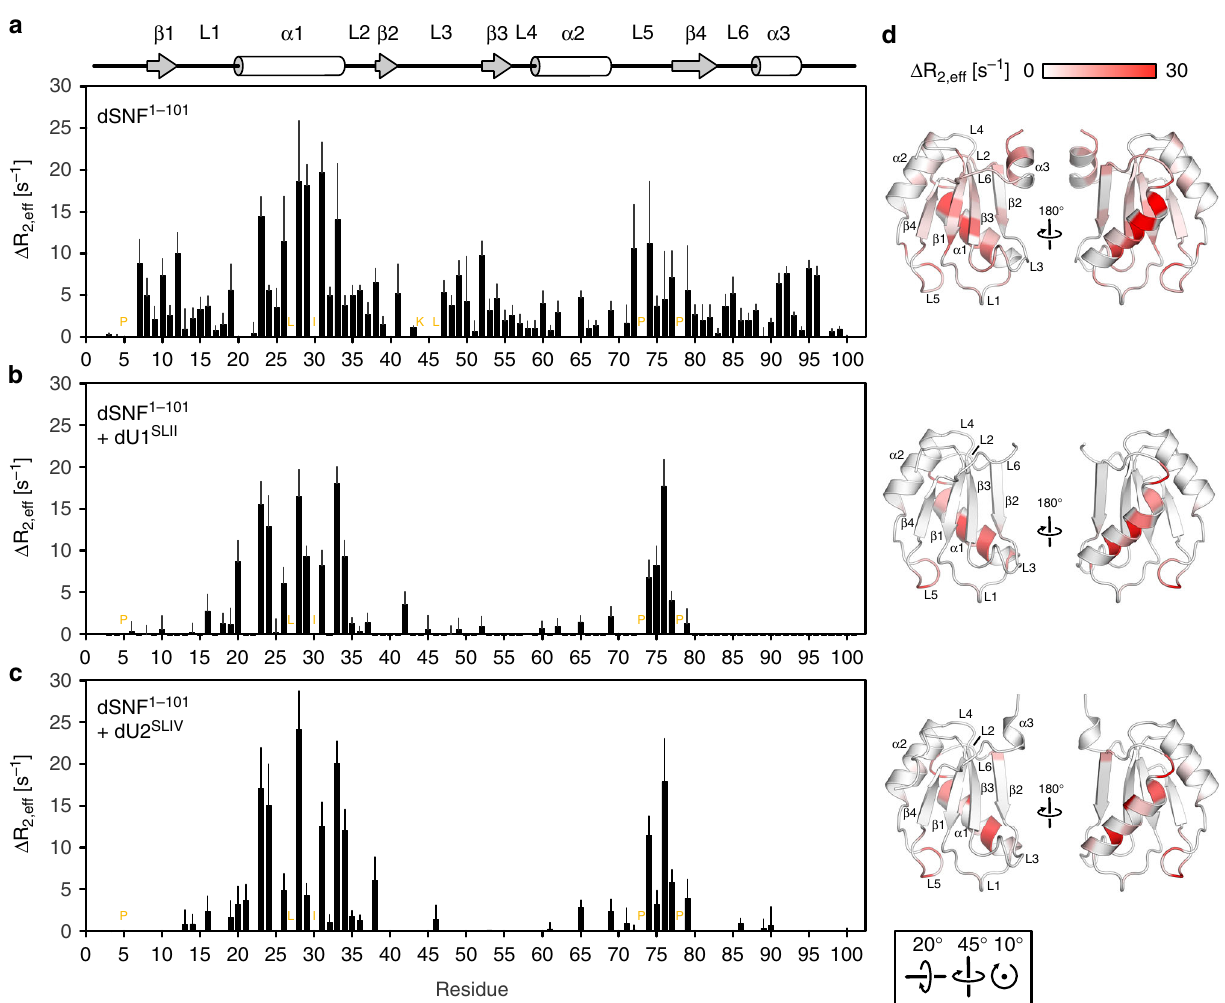
Fig. 2 dSNF 1-101 15 N/ 1 H backbone dynamics change upon RNA binding. a – c Values of Δ R 2,eff , calculated from end points of a CPMG experiment; Δ R = R ν – R ν 2,eff 2,app ( CPMG 50 Hz) 2,app ( CPMG 1000 Hz). Positions of secondary structure elements are shown on the top. a dSNF dU1 SLII , c dSNF 1-101 bound to dU2 SLIV . Errors were determined from the propagation of base plane rms noise. In a , b and c , amides from residues L27 and I30 have no signal from exchange broadening, while in ( a ), amides from K44 and L46 are exchange-broadened and not quanti fi able (orange labels). Prolines (orange labels) do not yield a signal. 50 mM KCl, 20 mM sodium cacodylate, pH 6.5, in 90% 1 H 2 O, 10% 2 H 2 O; 23 °C; 700 MHz. d Orthogonal views of Δ R 2,eff values mapped onto the structure of dSNF 1 – 96 in isolation (top), bound to dU1 SLII (middle) and bound to dU2A ′ and dU2 SLIV (bottom). A scale bar is shown on the top. The orientation of the left panels relative to Fig. 1b is shown at the